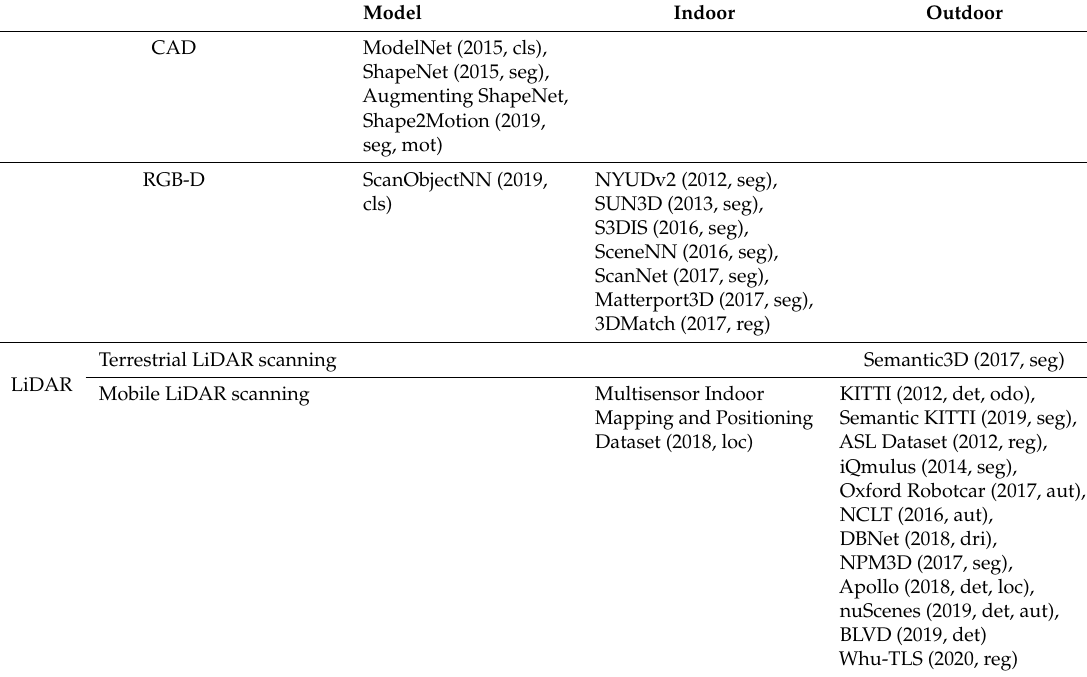
Table 2. Categorization of benchmark datasets. (cls: classification, seg: segmentation, loc: localization, reg: registration, aut: autonomous driving, det: object detection, dri: driving behavior, mot: motion estimation, odo: odometry, CAD: computer-assisted design, LiDAR: light detection and ranging.). Model Indoor Outdoor CAD ModelNet (2015, cls), ShapeNet (2015, seg), Augmenting ShapeNet, Shape2Motion (2019,